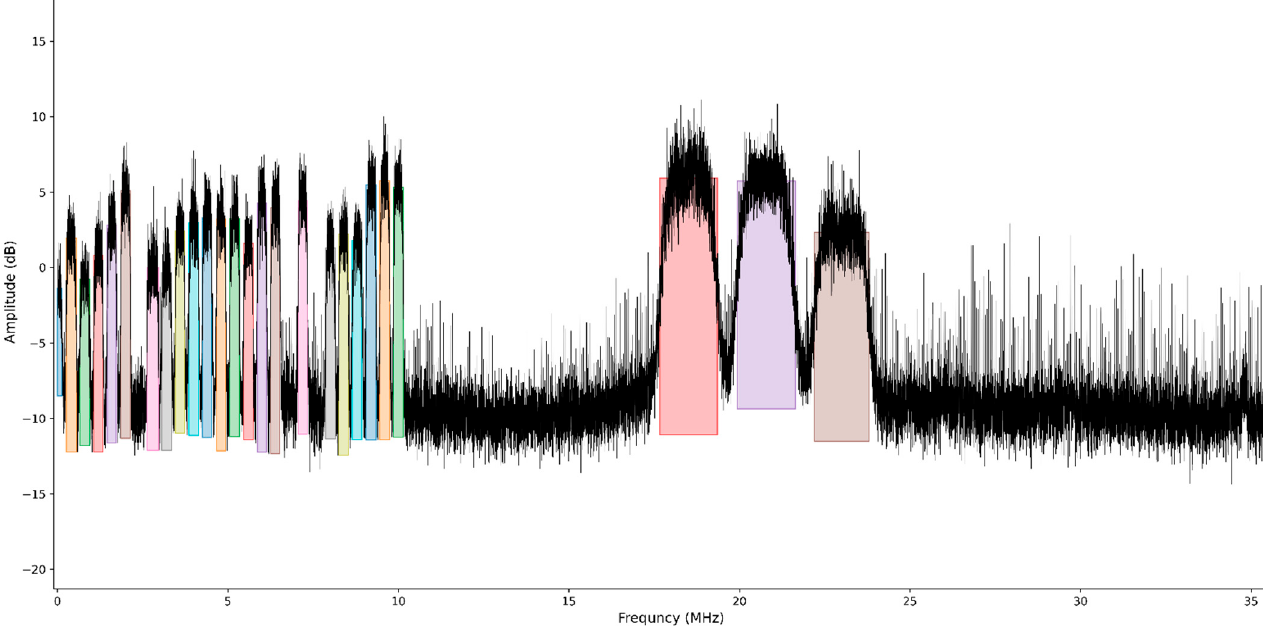
Figure A3. Example3 of the actual satellite broadband power spectrum set.